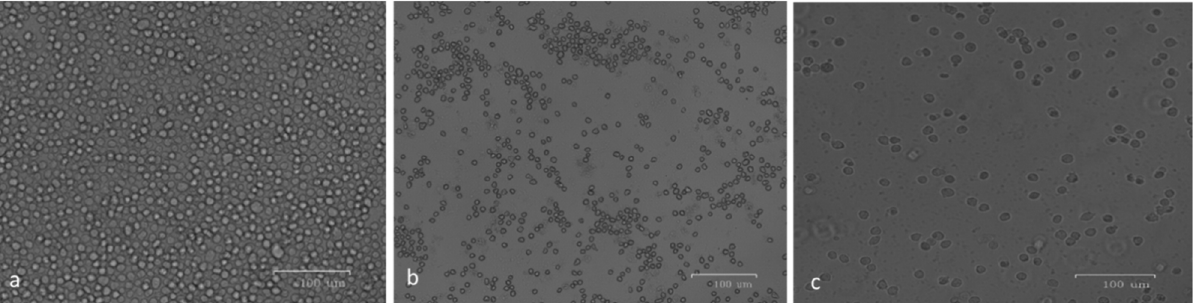
Figure 7: Morphological changes in MOLT4 cells after treatment for 24 h with ZnO – TiO 2 – chitosan – escin bio - nanocomposite. ( a ) Untreated control cells, ( b ) cells treated with 30 μ g · mL − 1 , and ( c ) 40 μ g · mL − 1 of ZnO – TiO 2 – chitosan – escin bio - nanocomposite. These are represen - tative images of the experiment performed in triplicates with magni fi cation at 20 ×